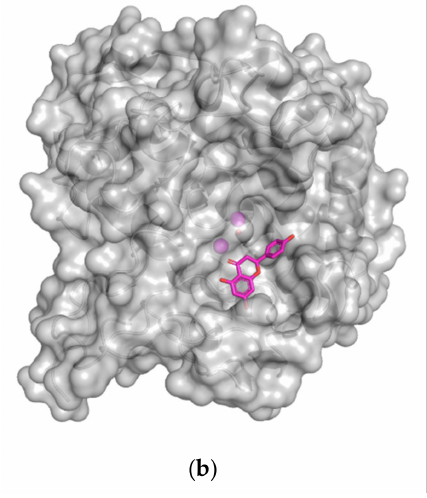
Figure 5. The ligands ( a ) naringin (green) and ( b ) naringenin (magenta) bound to Ab TYR are shown as sticks, while Cu ions (magenta) and the conserved water (red) are shown as spheres. Protein surfaces were rendered with PyMOL.